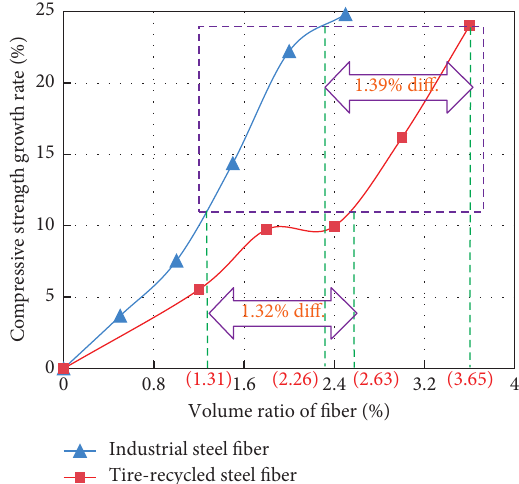
Figure 2: The compressive strength growth rate of two types of steel fiber reinforced concrete.